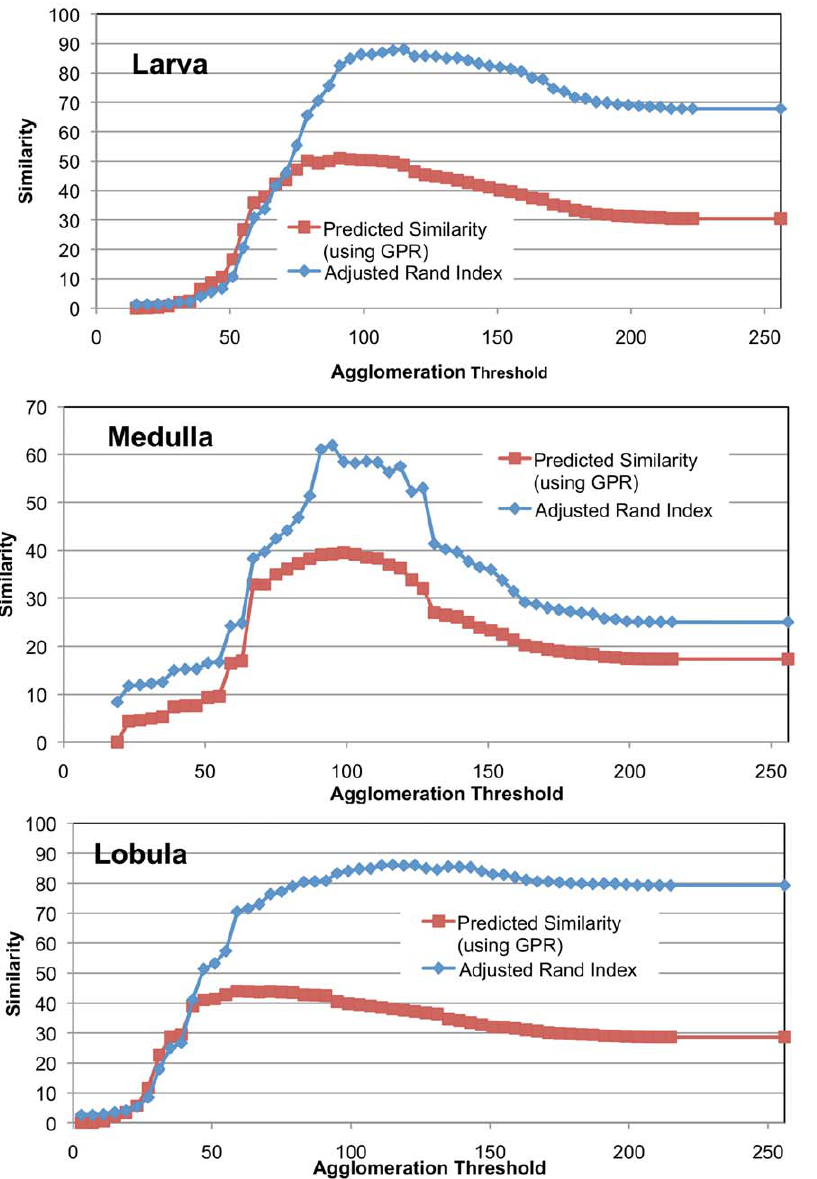
Figure 7. Shows the predictiveness of GPR similarity measure compared to the actual adjusted Rand index computed with an expert-created ground truth. The y-axis gives similarity as a function of different agglomeration thresholds. The agglomeration is based on the mean intensity of the pixel-wise boundary prediction.